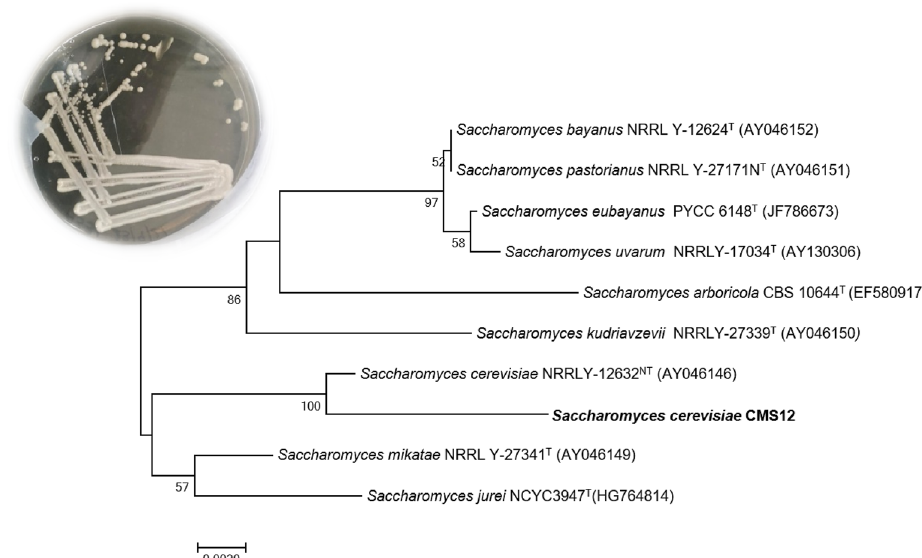
Figure 1. Phylogenetic tree based on ITS and D1/D2 gene sequence comparison showing the position of S. cerevisiae CMS12 and other related species of genus Saccharomyces .